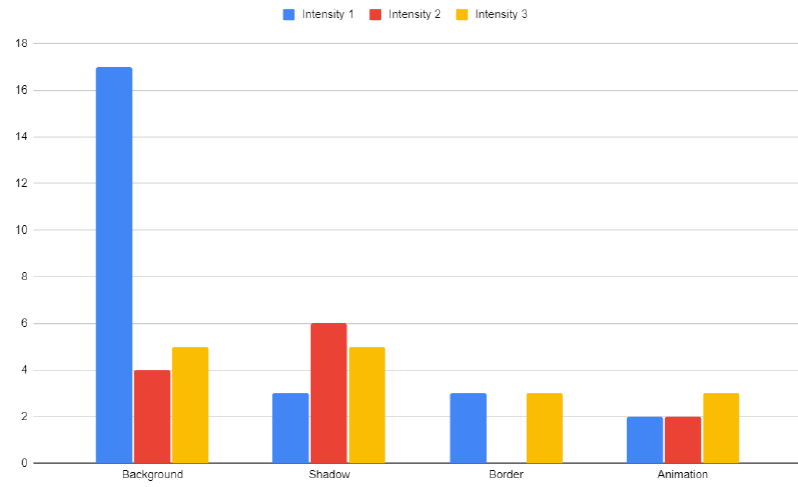
Figure 5. The number of user selections for featured products. Source: own elaboration.